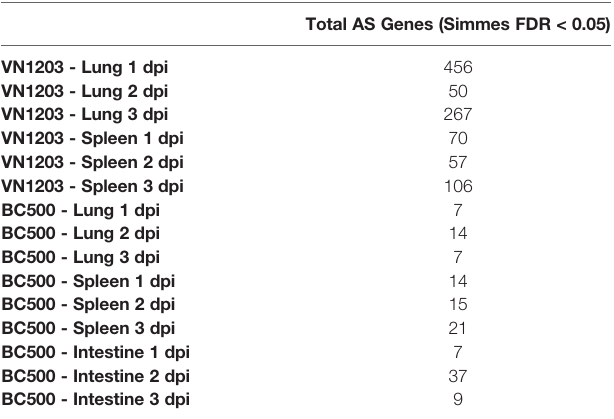
TABLE 2 | Counts of alternatively spliced (AS) transcripts in tissues of ducks infected with VN1203 or BC500. Total AS Genes (Simmes FDR <